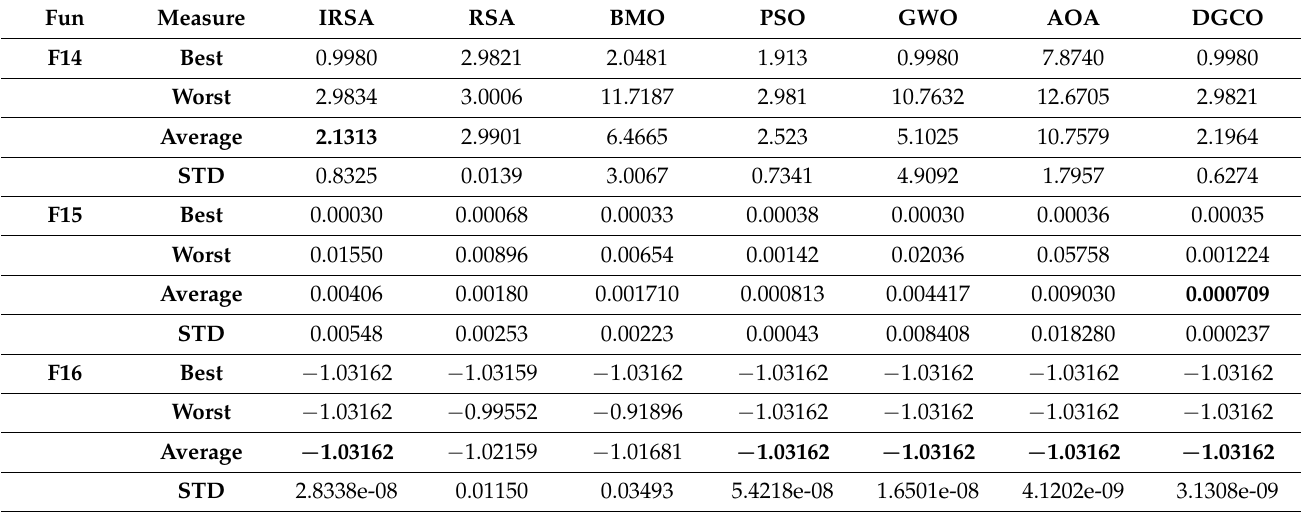
Table 2. Results for fixed-dimension functions considering 500